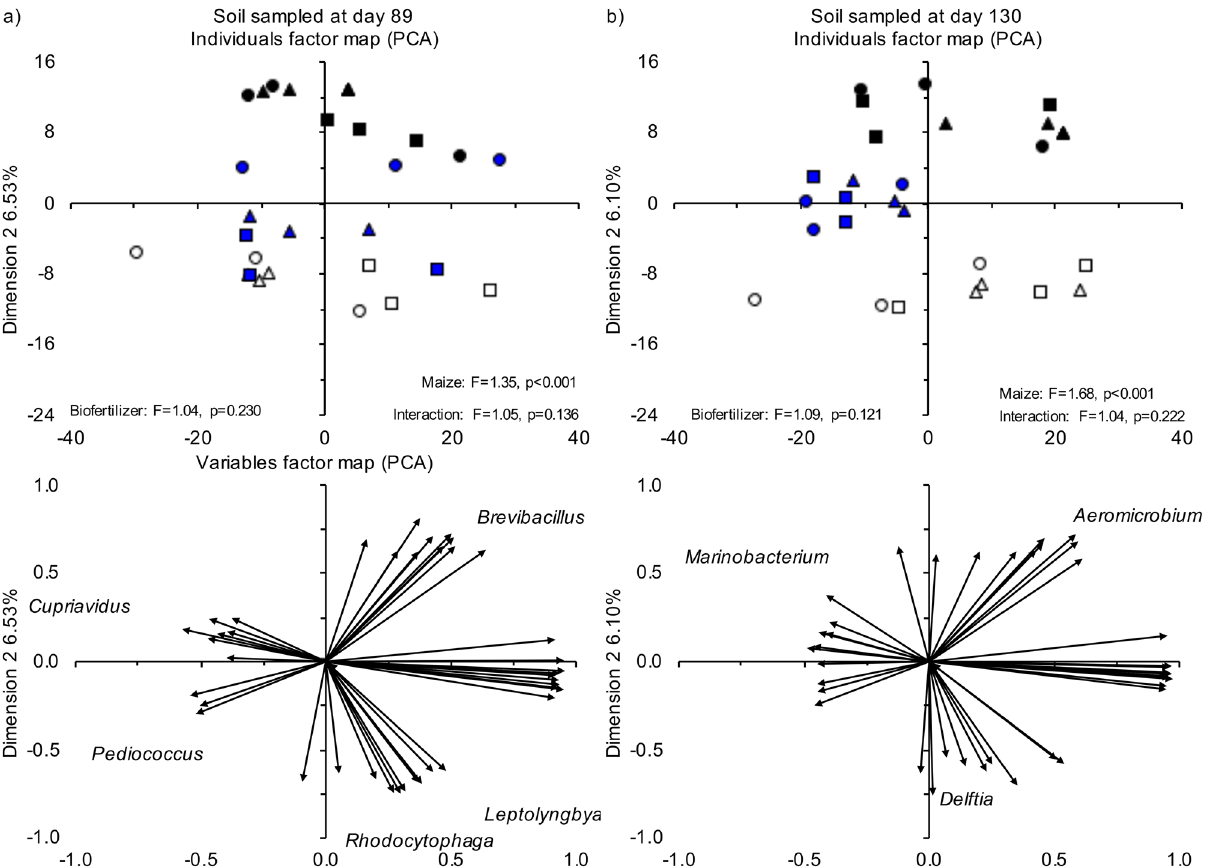
Figure 5. Principal component analysis (PCA) with all the bacterial groups assigned up to the taxonomic level of genus after ( a ) 89 days and ( b ) 130 days in the uncultivated unamended soil (white square), uncultivated soil amended with biofertilizer (white circle) and uncultivated soil amended with sterile biofertilizer (white triangle), unamended non-rhizosphere soil (blue square), biofertilizer amended non-rhizosphere soil (blue circle) and sterile biofertilizer amended non-rhizosphere soil (blue triangle), and unamended rhizosphere soil (black square), biofertilizer amended rhizosphere soil (black circle) and sterile biofertilizer amended rhizosphere soil (black